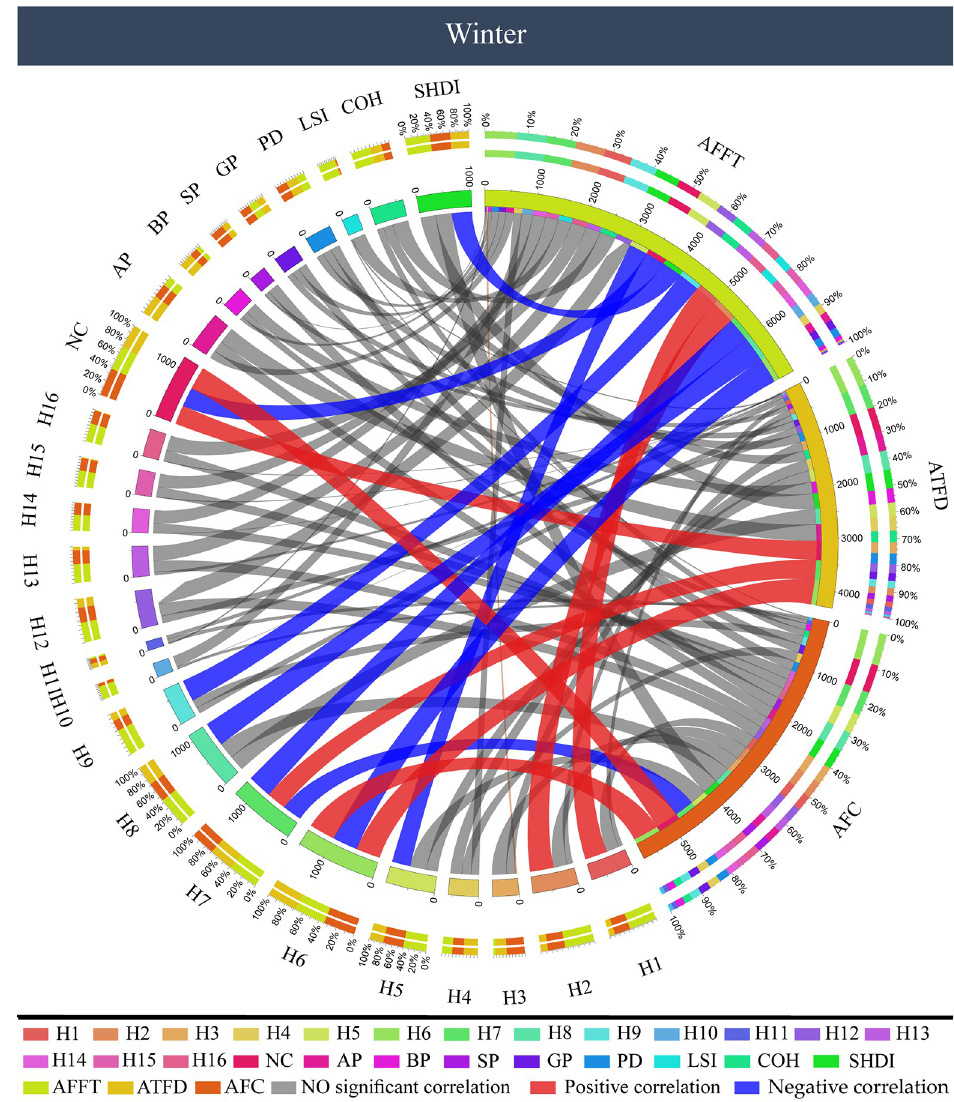
Fig 9. Correlation between color characteristics and visual behavior of forest color pictures in winter. AFFT: AOI first fixation time, ATFD: AOI total fixation duration, AFC: AOI fixation count.